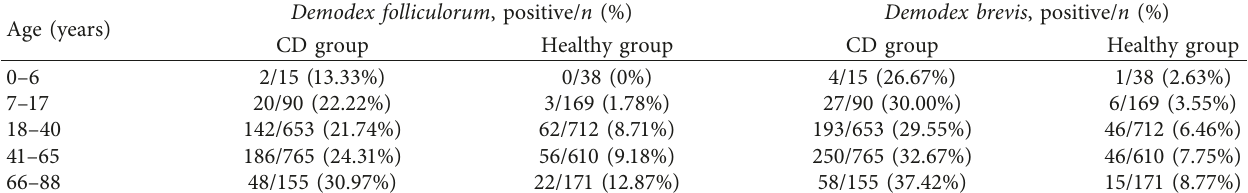
Table 1: Distribution of Demodex folliculorum and Demodex brevis by age in the CD and healthy groups.